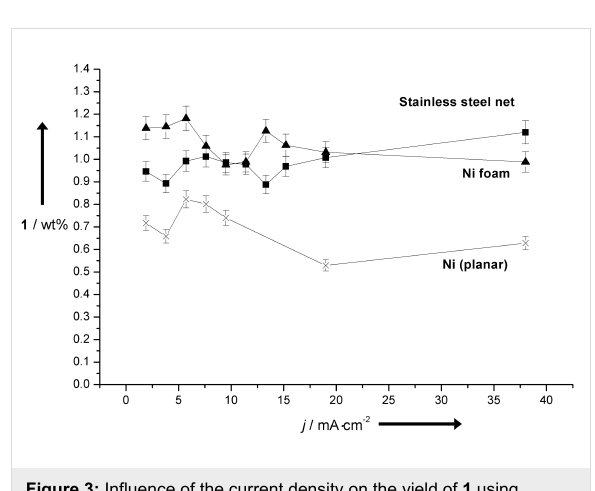
Figure 3: Influence of the current density on the yield of 1 using different geometries of anodic